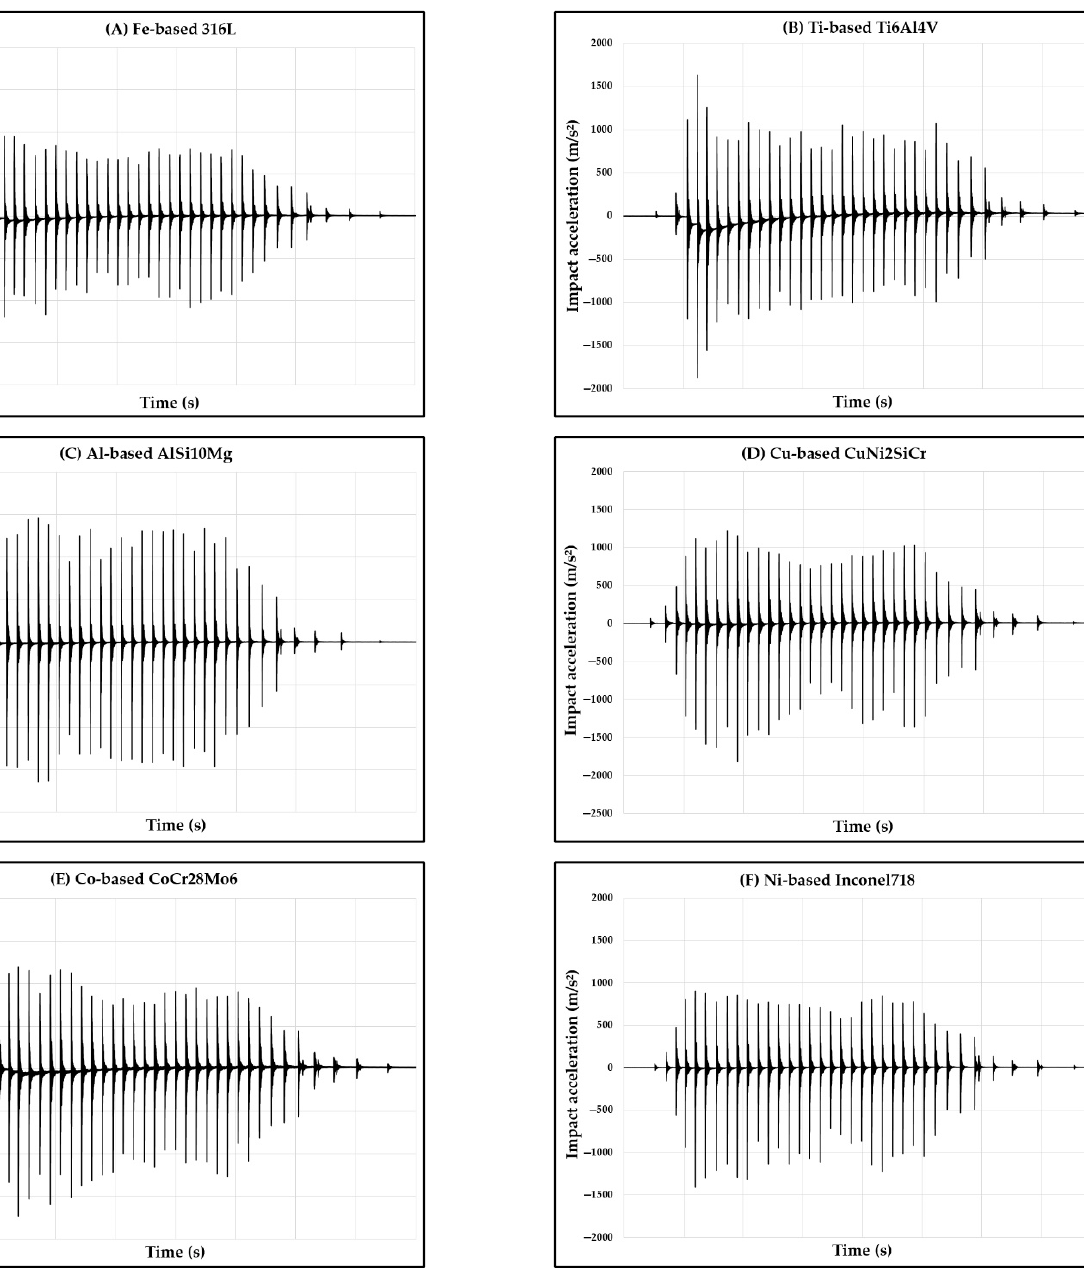
Figure 6. In situ acceleration measurements taken during impact tests with ≈ 30 strikes: ( A ) Fe-based 316L, ( B ) Ti-based Ti 6 Al 4 V, ( C ) Al-based AlSi 10 Mg, ( D ) Cu-based CuNi 2 SiCr, ( E ) Co-based CoCr 28 Mo 6 , and ( F ) Ni-based Inconel718 samples.